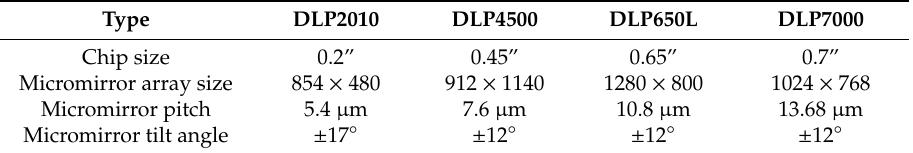
Table 1. Near-infrared DMD chipsets launched by Texas Instruments